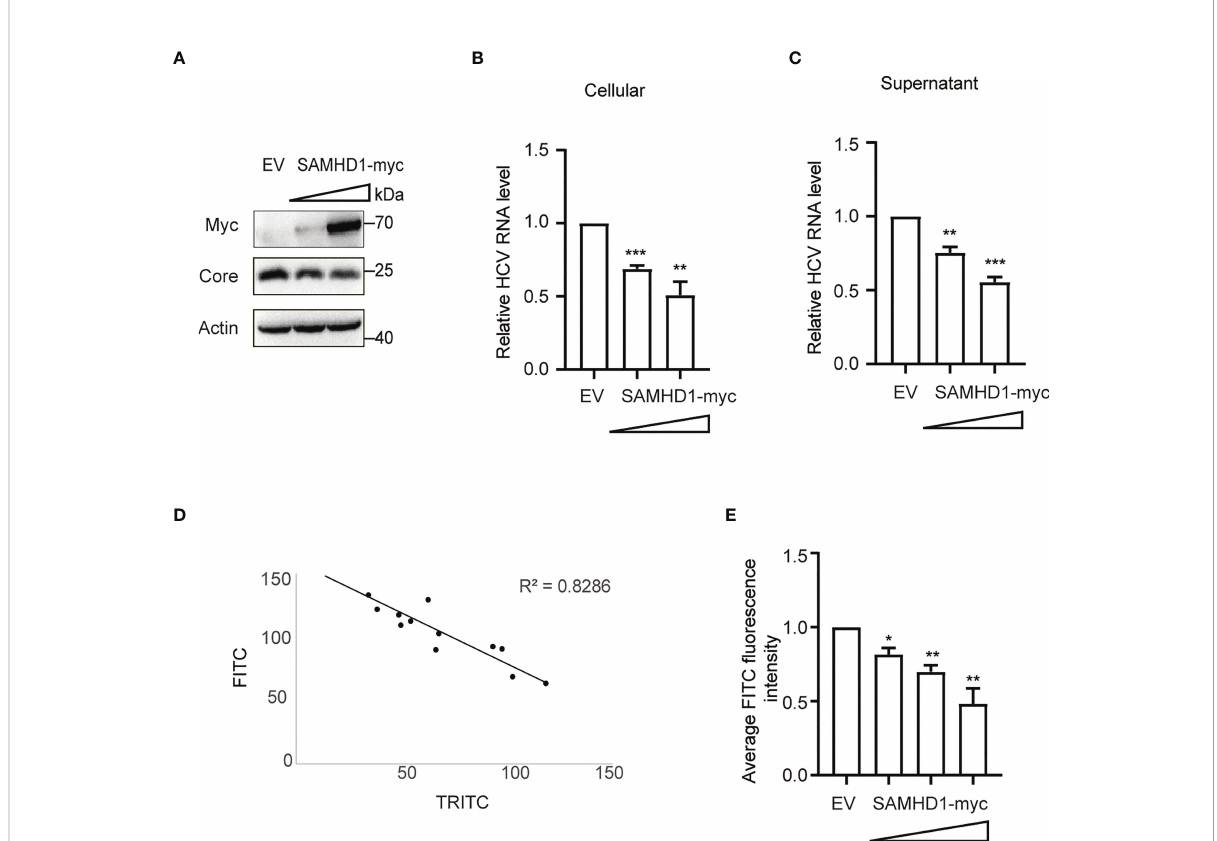
FIGURE 3 Extrogenous SAMHD1 inhibits HCV replication. Huh7.5.1 cells with extrogenous SAMHD1 overexpression were infected with JFH1 HCVcc (MOI = 0.2) for 48 h. (A) Cell lysates were detected by Western blotting to analyze the expression levels of SAMHD1 and HCV core proteins. b -actin was used as a sample loading control. (B) Levels of HCV RNA in cells were evaluated by qRT-PCR. (C) Levels of infectious progeny viruses in culture supernatants were tested by infecting naïve Huh7.5.1 cells, followed by qRT-PCR analysis of HCV RNA in cells at 72 hpi. All of the data are representative of three independent experiments. For panels (B, C) data of SAMHD1 groups are normalized to the control group, whose value is set to 1. (D) Huh7.5.1 cells with extrogenous SAMHD1 overexpressing infected with JFH1 HCVcc and processed by immuno fl uorescence staining. The correlation between fl uorescence intensity of SAMHD1 (TRITC) and HCV core proteins (FITC) was detected by high content screening. (E) Data of the inhibition on average fl uorescence intensity of HCV core protein by different concentrations of extrogenous SAMHD1 are plotted as a histogram. The value of the control group is arbitrarily set to 1 (mean values ± SD; n = 3). *P<0.05; **P<0.01, and